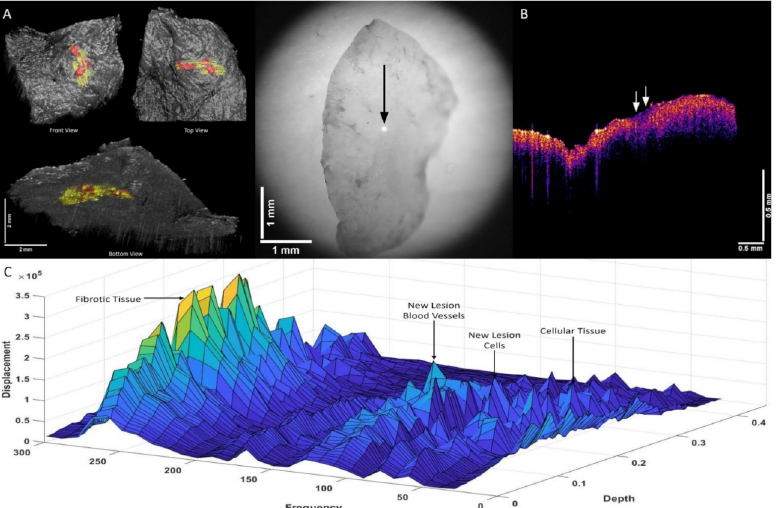
Figure 5. Three-dimensional color-coded OCT images ( A ) of a superficial basal cell carcinoma (BCC) on left and a camera image in center, illustrating the location of new cells (80 Hz) and new lesion blood vessels (130 Hz) (red), and fibrotic tissue (260 Hz) (yellow). The camera image is shown in the center with the arrow pointing to where the VOCT data were collected. ( B ) is an OCT image of a cross-section of superficial BCC and the arrows indicate where the data were collected. ( C ) shows a 3D plot of weighted displacement versus frequency and versus depth, showing the location of skin cells (50 Hz), new cells (80 Hz), dermal collagen (100 Hz), and fibrotic tissue (260 Hz) in a superficial BCC.